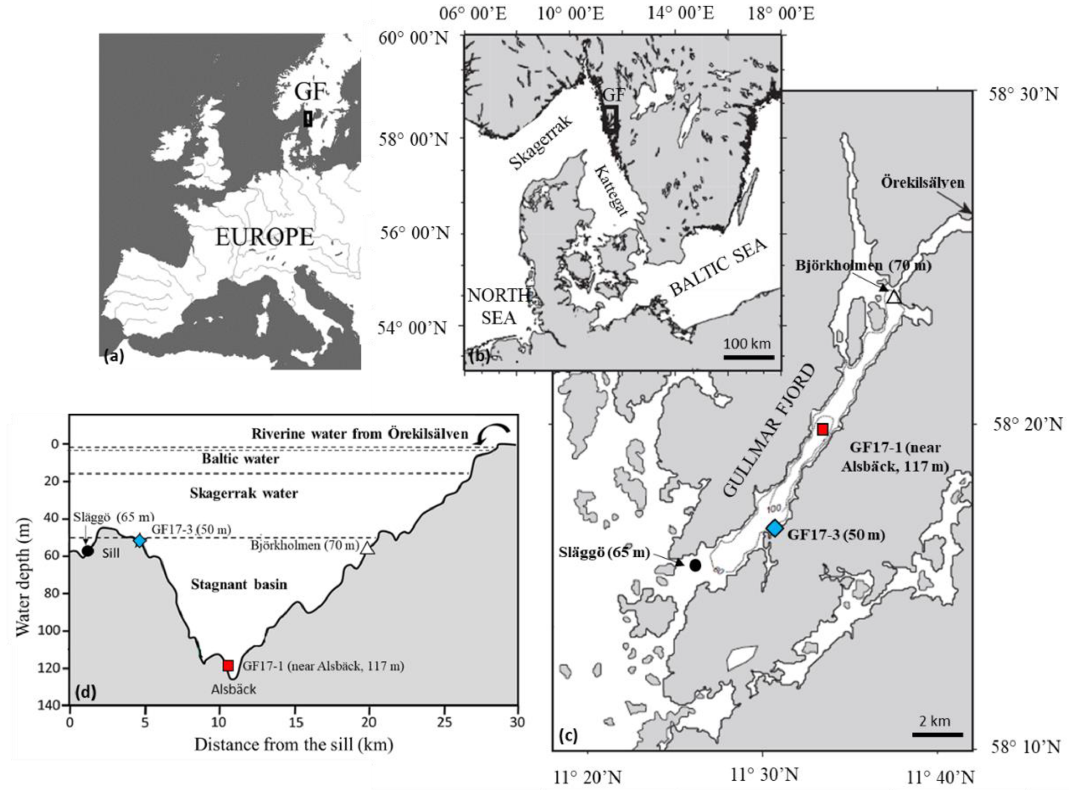
Figure 2. (a–c) Location of studied stations in the Gullmar Fjord (Sweden); blue diamond: GF17-3 oxic station (50m water depth); red square: GF17-1 hypoxic station (117m water depth); dark circles: monitoring stations Släggö (65m water depth) and Björkholmen (70m water depth). (d) Transect from the sill with the four Gullmar Fjord water masses and the studied stations (modified from Arneborg et al.,